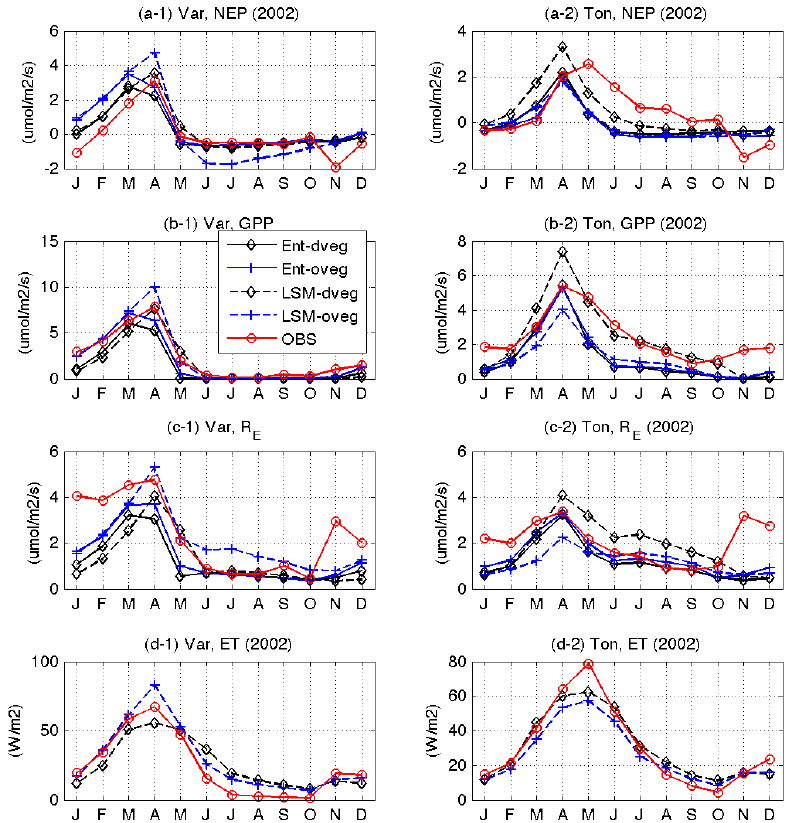
Figure 7. Monthly fluxes in the Vaira and Tonzi ranches for 2002: (a) NEP, (b) GPP, (c) R E and (d)